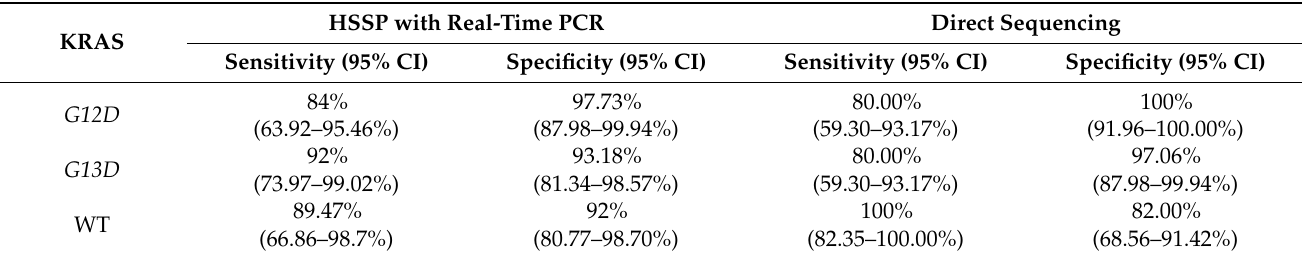
Table 1. Comparison of specificity and sensitivity of HSSP and direct sequencing for KRAS mutation detection in clinical